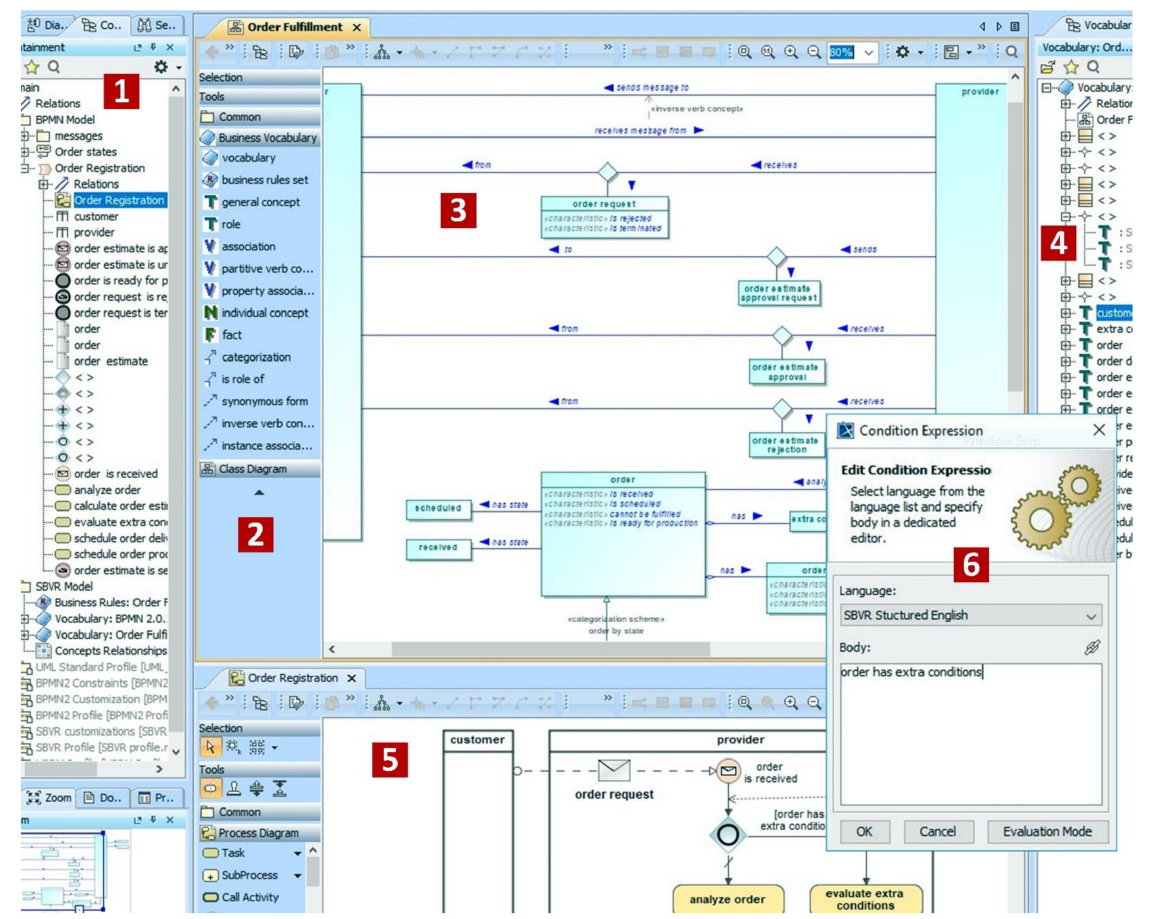
Figure 3. The MagicDraw GUI setup for working with BPMN and SBVR models.